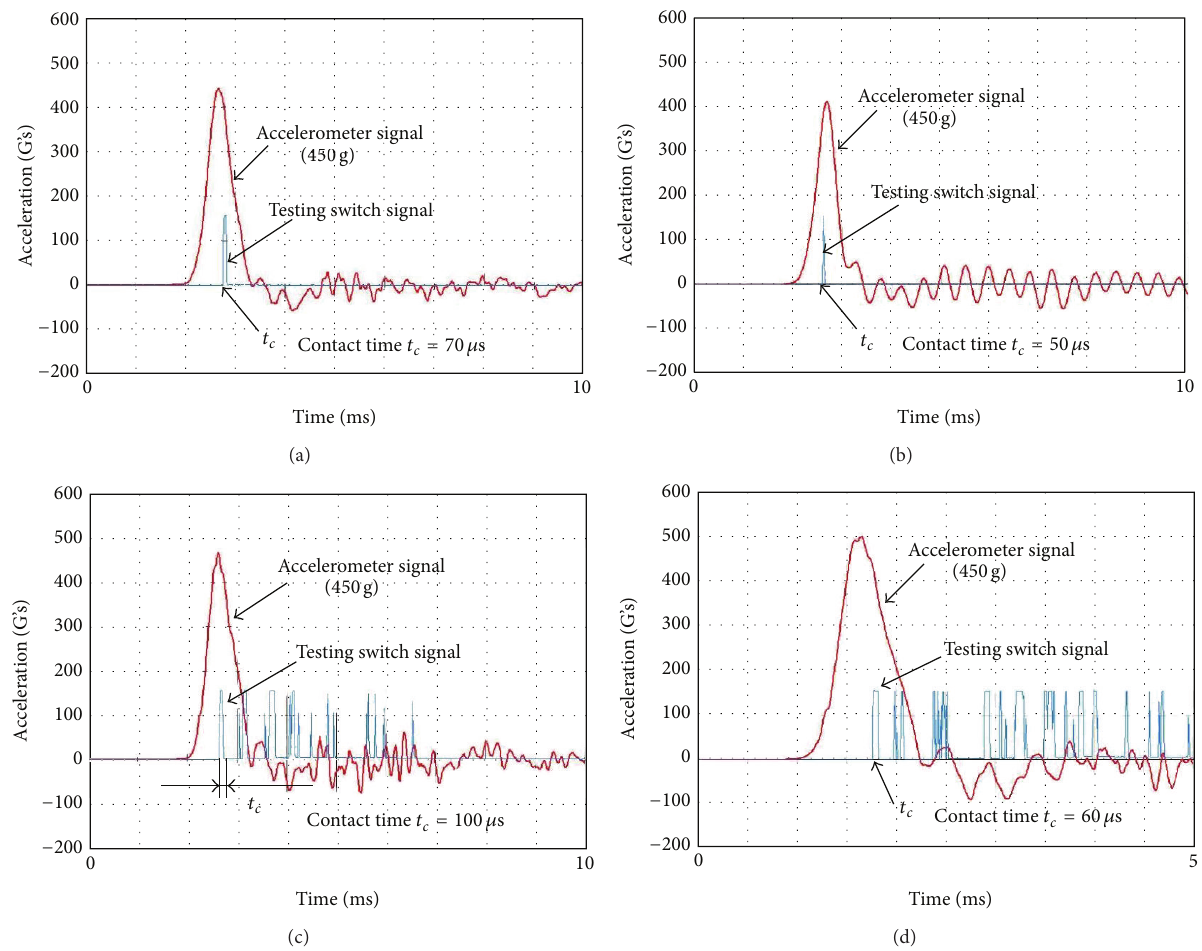
Figure 11: Shock test results of the switch in the direction of (a) 𝑋 -axis direction, (b) 45 ∘ with the 𝑋 -axis direction in the XOY plane, (c) 𝑍 -axis direction, and (d) 45 ∘ with the 𝑍 -axis direction in the XOZ